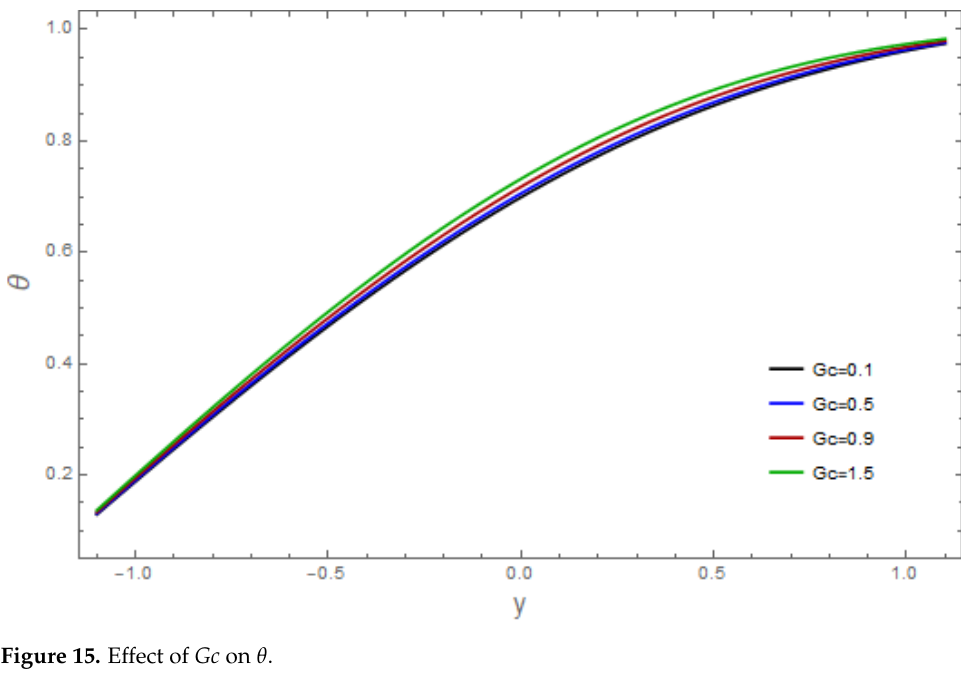
Figure 15. Effect of 𝐺𝑐 on 𝜃 .